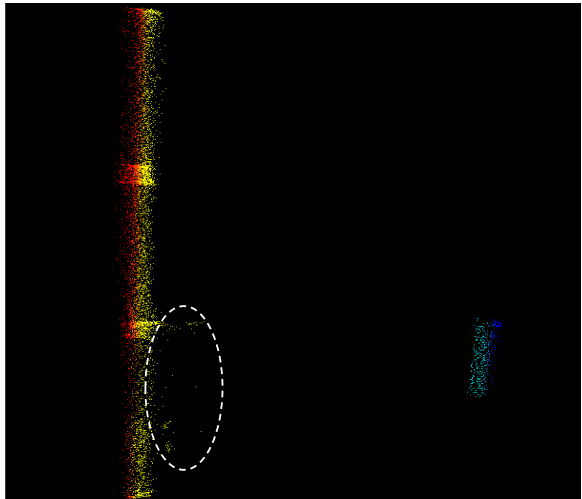
Figure 6. Side view of the 3D points belonging to the target (shades of blue) and uniform background. Circled in white, we Figure 4. Variation of distance measurement with respect to different incident angles